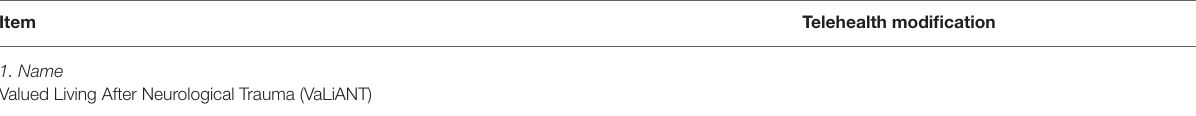
TABLE 1 | TIDieR checklist describing the Valued Living After Neurological Trauma intervention and telehealth